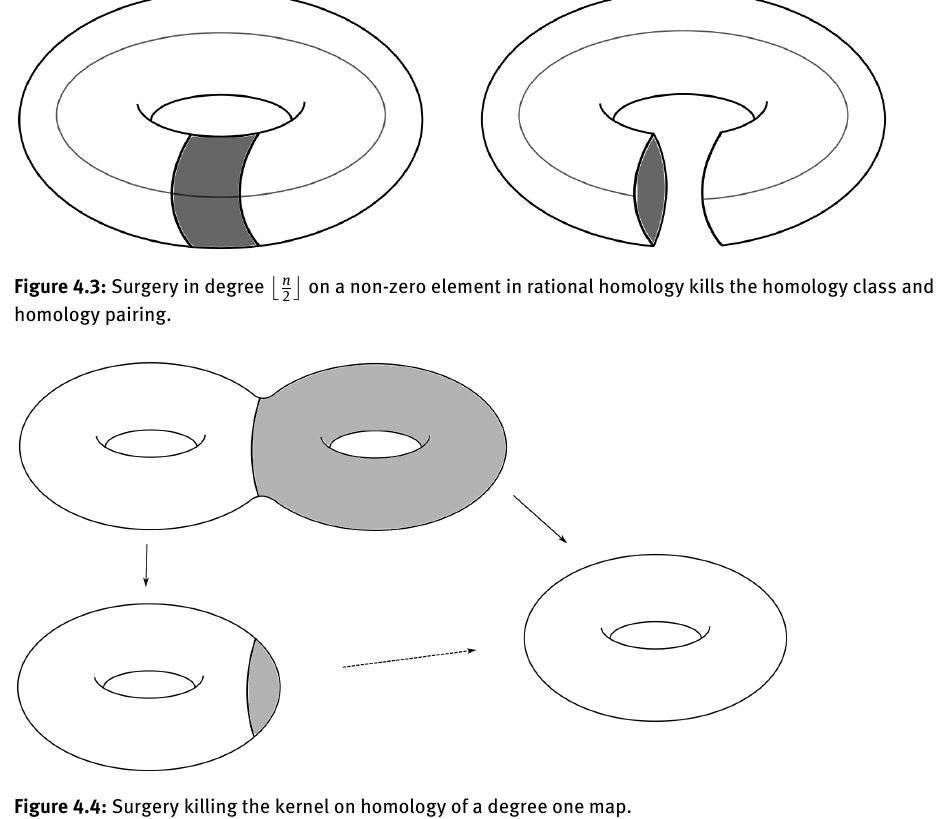
Figure 4.4: Surgery killing the kernel on homology of a degree one